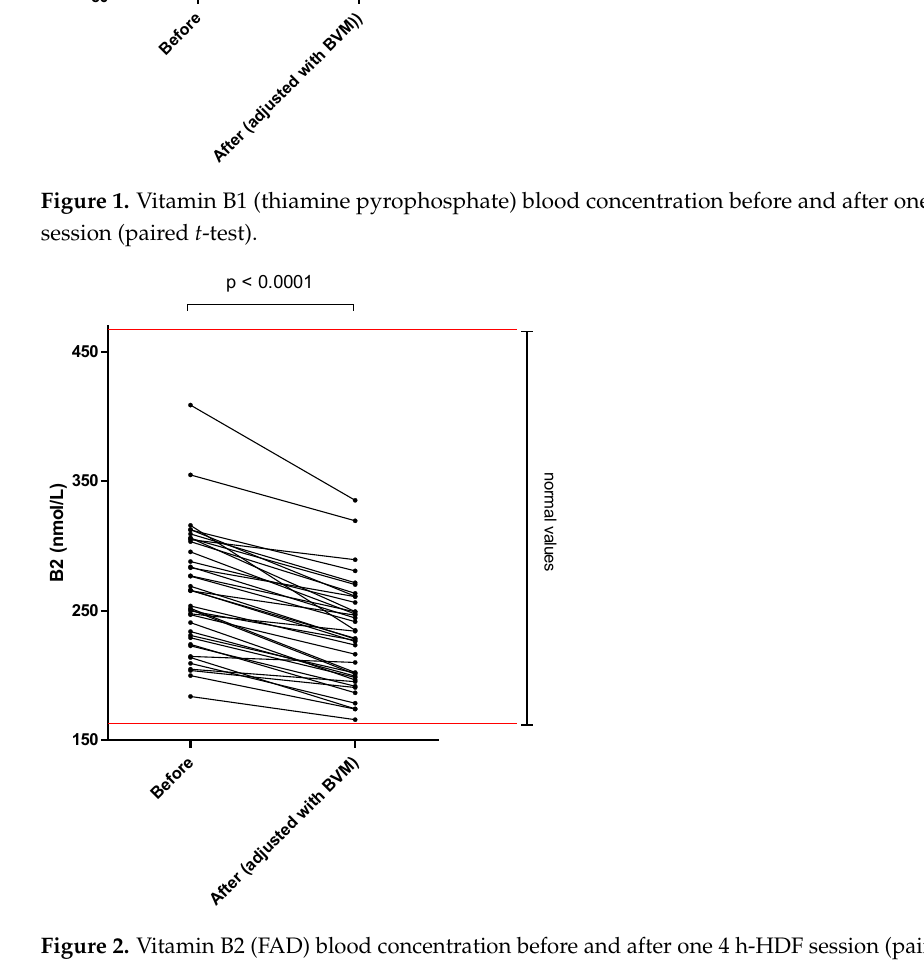
Figure 3. Vitamin B6 (pyridoxal phosphate) blood concentration before and after one 4 h-HDF ses- sion (paired t- test).